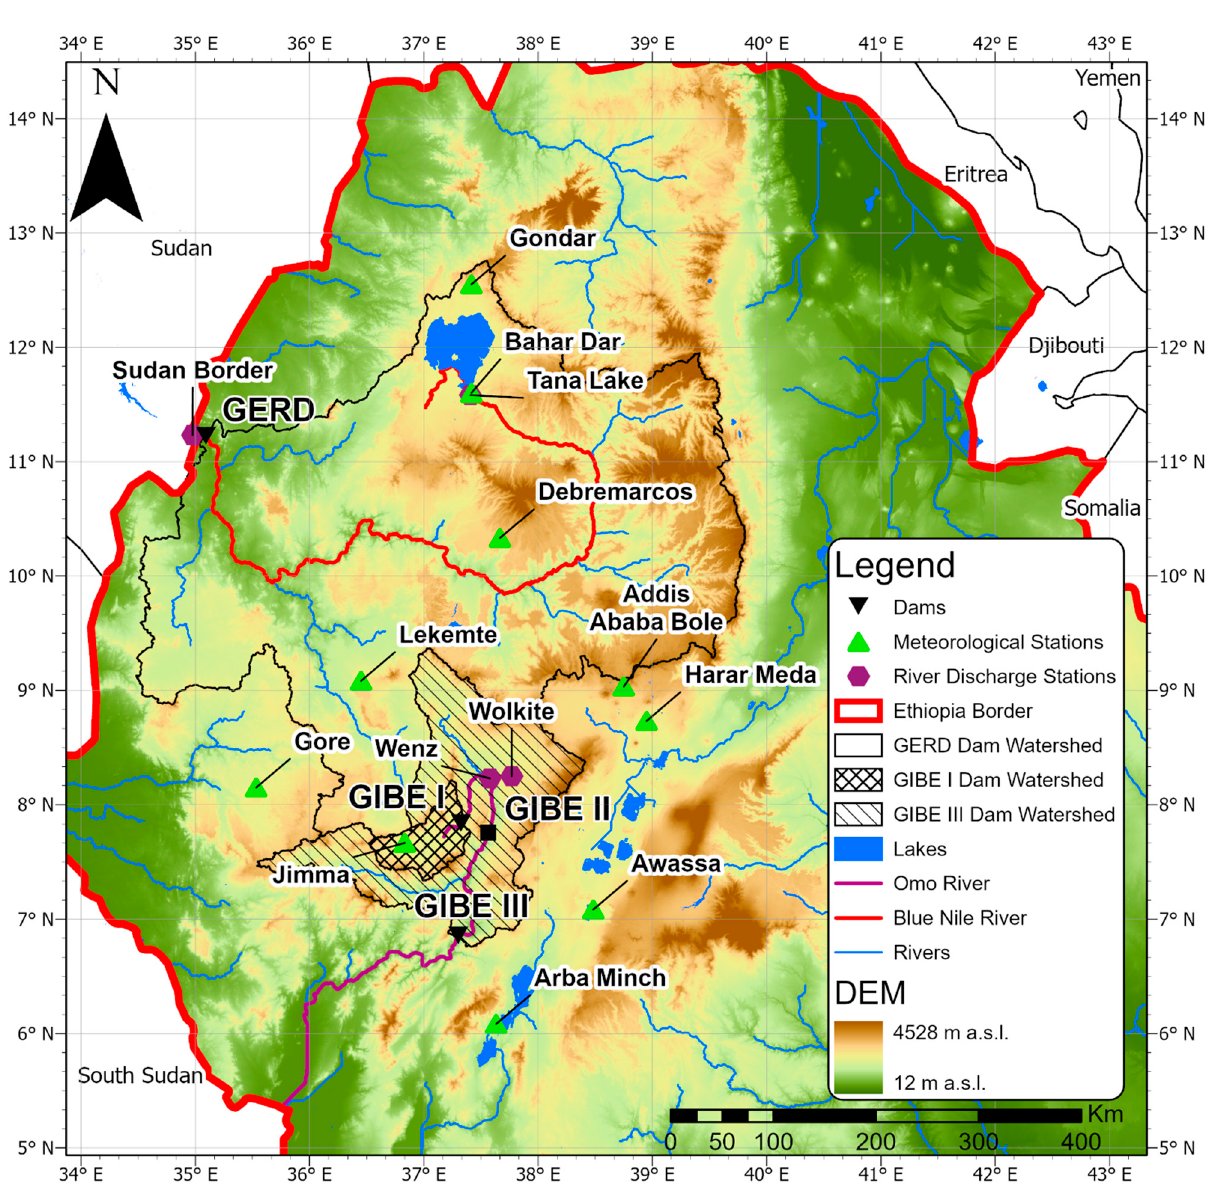
Figure 1. Regions of study in Ethiopia. DEM (Digital Elevation Model) of Blue Nile and Omo catchments closed at dam sites. We also report the stream flow and meteorological stations used in the study.